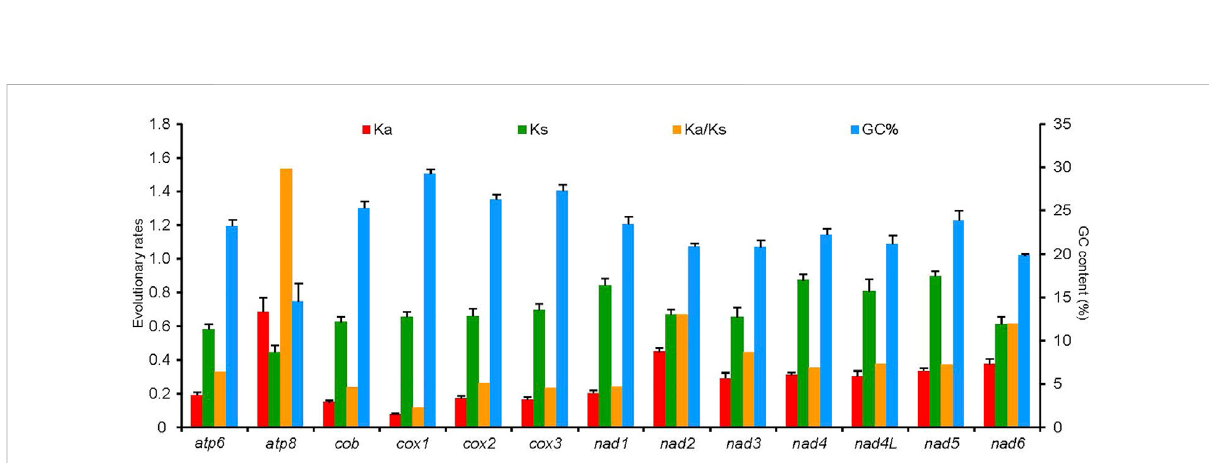
FIGURE 7 Evolutionary rates of 13 protein-coding genes in the mitochondrial genomes of 50 spider species of the retrolateral tibial apophysis clade. The left Y -axis provides the substitution rate of the mitochondrial gene, while the right Y -axis provides the G + C content. Synonymous nucleotide substitutions per synonymous site ( Ks ) and nonsynonymous nucleotide substitutions per nonsynonymous site ( Ka ) are calculated using the Kumar method. The standard error estimates are obtained by a bootstrap procedure (1,000